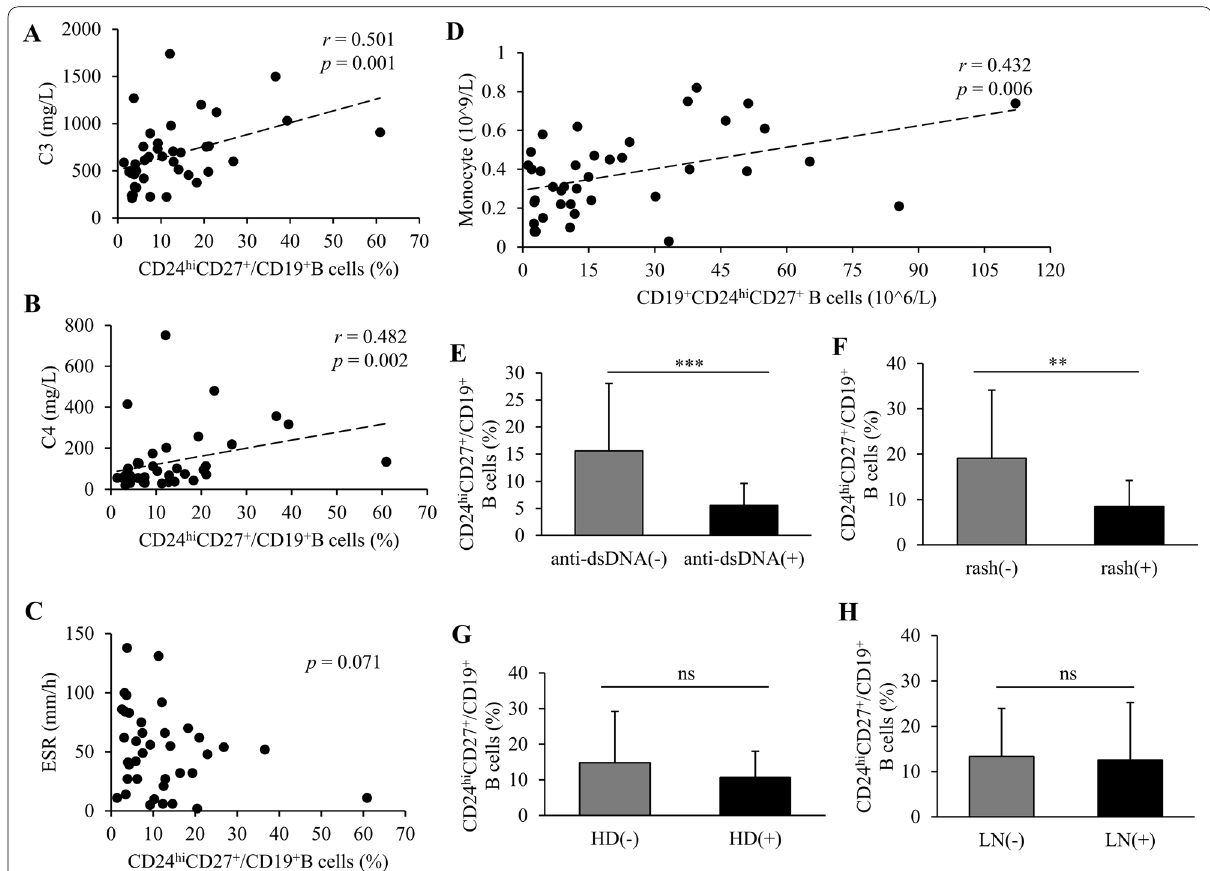
Fig. 3 Association of the proportion of CD19 + CD24 hi CD27 + B cells with SLE-related parameters. A – D Correlation of the proportion of CD19 + CD24 hi CD27 + B cells with level of complement C3, C4, ESR and monocyte number in peripheral blood. E The proportion of CD19 + CD24 hi CD27 + B cells from anti-dsDNA negative patients (n 30) and anti-dsDNA positive patients (n 11). F – H The proportion of = = CD19 + CD24 hi CD27 + B cells in SLE patients with rash (n 24) and without rash (n 17); with hematological disorders (n 19) and without = = = hematological disorders (n 22); with nephritis (n 24) and without nephritis (n 17). * P < 0.05, ** P < 0.01, *** P < 0.001; ns, not significant = = =